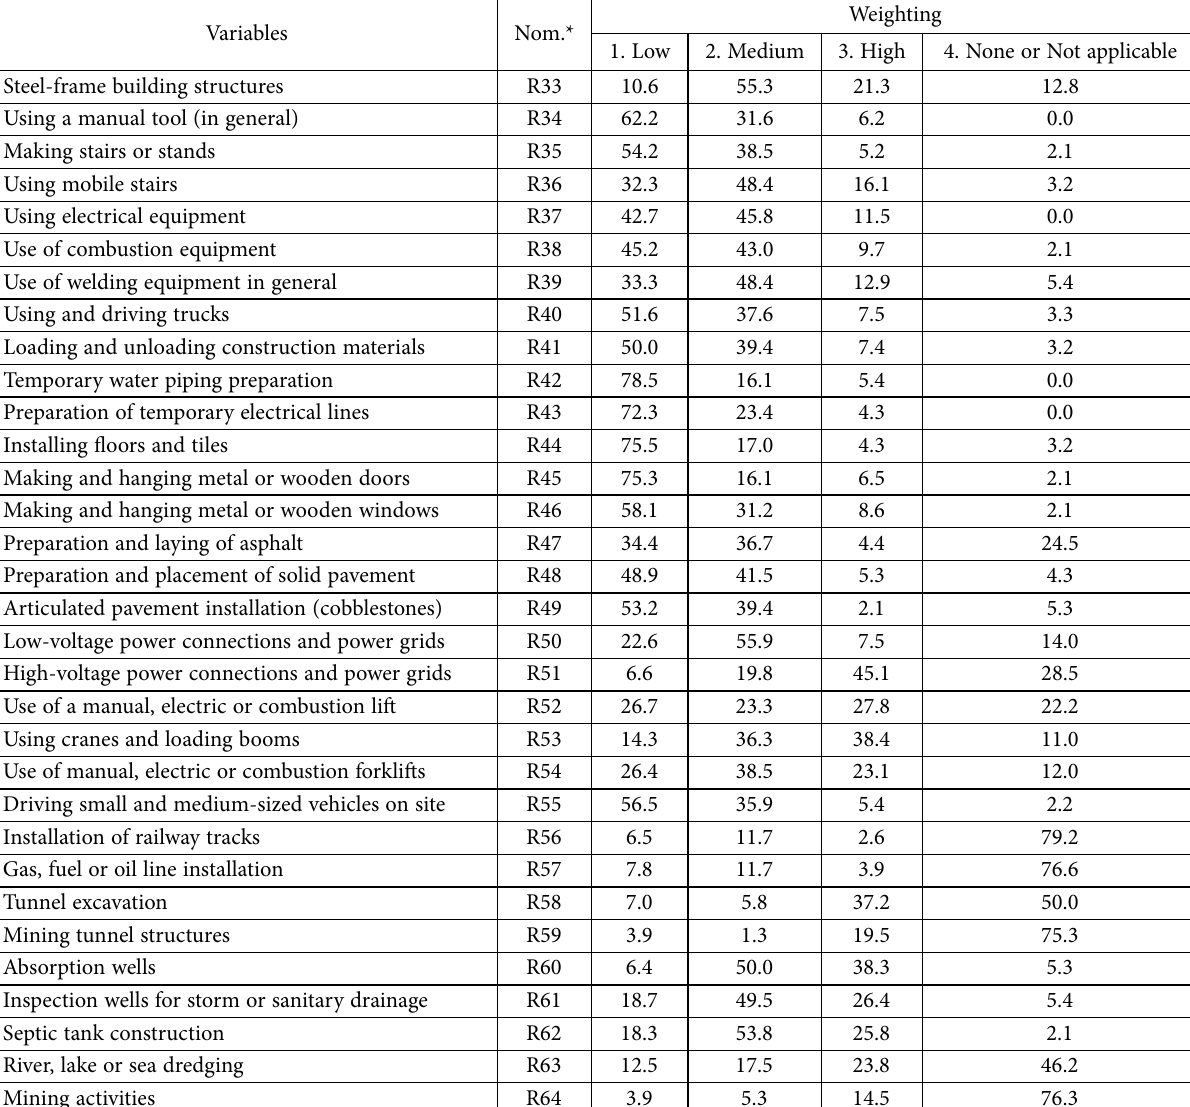
Table 2. Frequencies of the 64 risk-weighting variables in each construction activity (Part